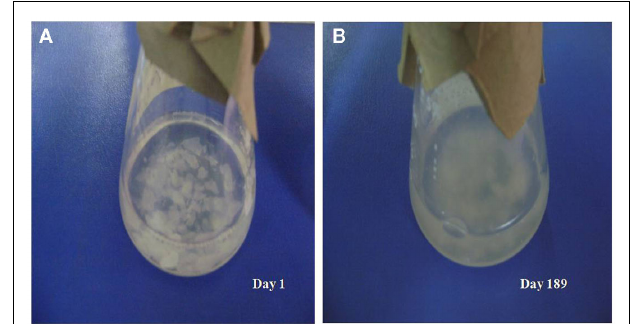
FIGURE 1 | External observation of the utilization of shrimp chitin in the MW–CC microcosm at room temperature (A) intact chitin chips at day 1 and (B) degraded chitin chips at day 189.